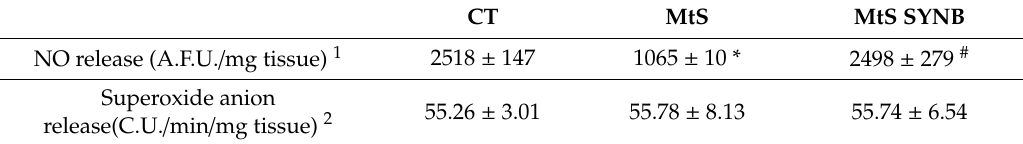
Table 3. Nitric oxide and superoxide anion release in endothelium-denuded mesenteric rings. CT MtS MtS SYNB NO release (A.F.U. / mg tissue) 1